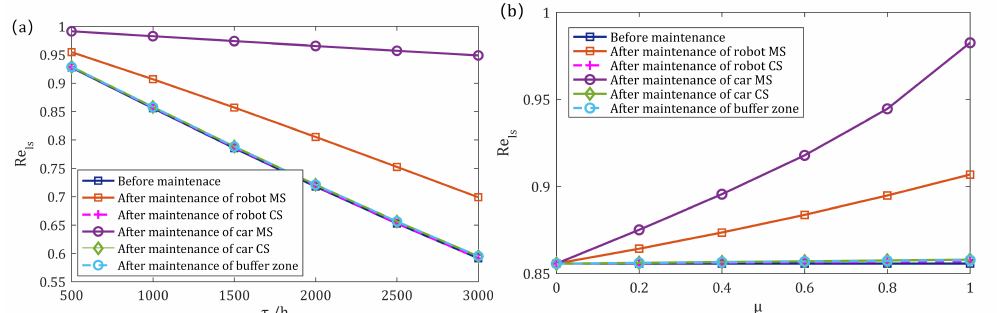
Figure 5. Reliability variations of the logistics subsystem before and after the element maintenance over the maintenance parameters. ( a ) Variations over the maintenance period. ( b ) Variations over the maintenance coefficient.